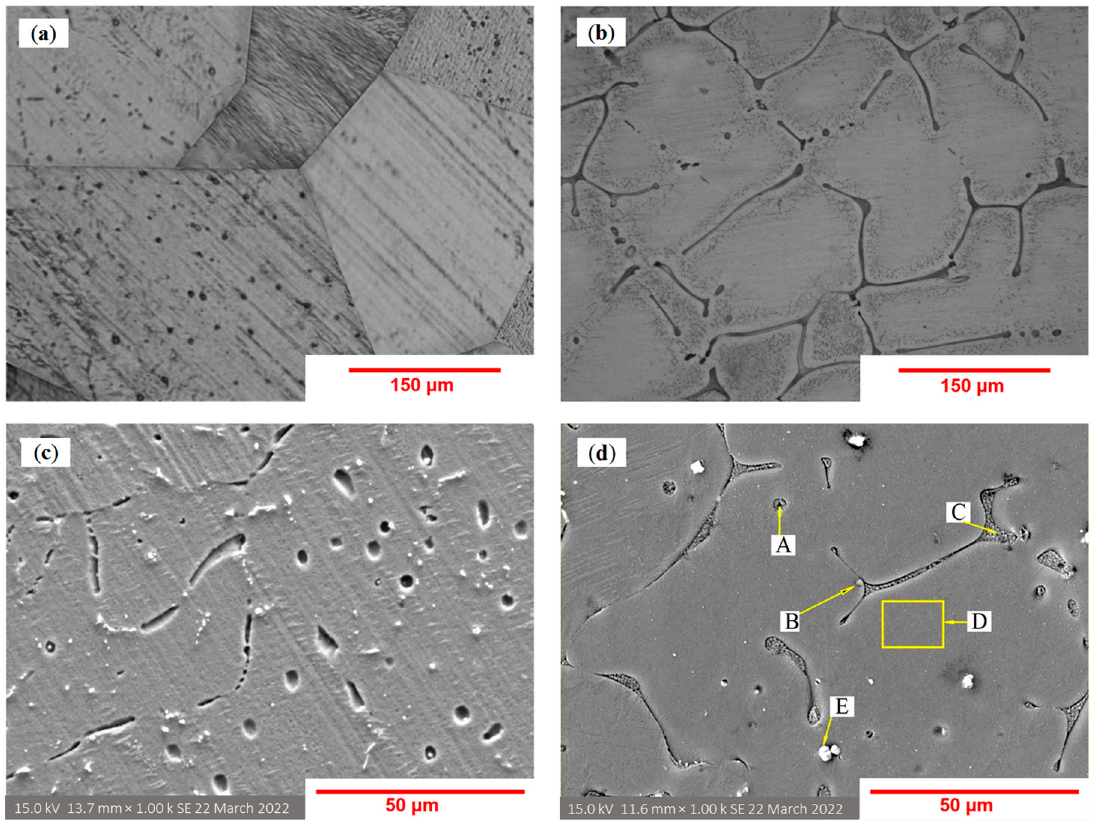
Figure 2. Optical microstructure of ( a ) CP Mg and ( b ) Mg-1.0Ca-0.5Sr alloy and their corresponding SEM images of ( c ) CP Mg and ( d ) Mg-1.0Ca-0.5Sr alloy. The marked yellow points and areas (A–E) in SEM images correspond to the EDS analysis locations in (Table 4). Table 4. Analysis of the Mg-1.0Ca-0.5Sr alloy’s chemical composition using EDS analysis and phase prediction using the modelled Mg–Ca–Sr thermodynamic phase diagram